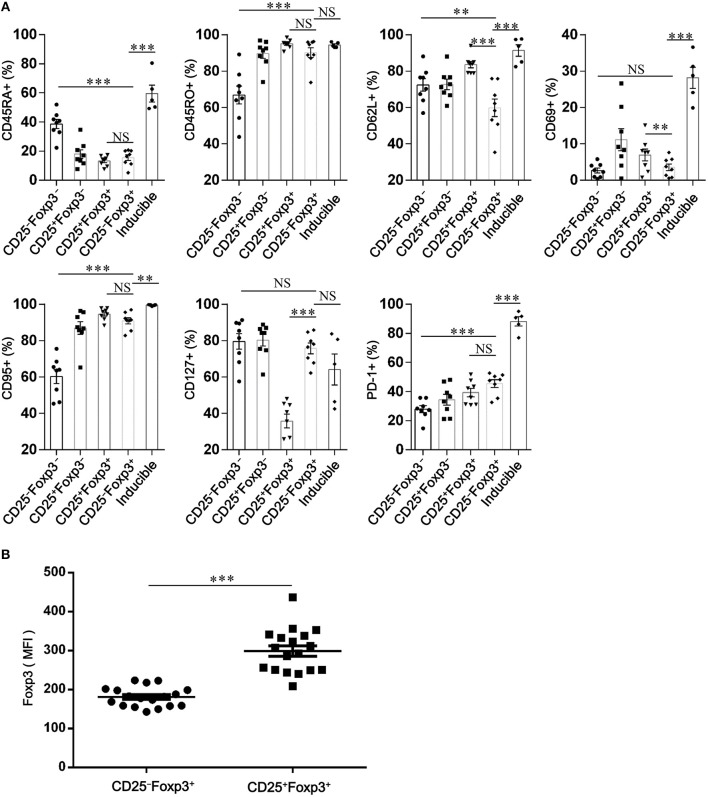
CD4+CD25−Foxp3+ T cells resemble activated conventional T cells in patients with chronic obstructive pulmonary disease (COPD). (A) Scatter plots depict the distribution of CD45RA, CD45RO, CD62L, CD69, CD95, CD127, and PD-1 amongst: peripheral CD4+ T cells subsets (CD4+CD25−Foxp3− T cells, CD4+CD25+Foxp3− T cells, CD4+CD25+Foxp3+ T cells and CD4+ CD25−Foxp3+ T cells) from SCOPD patients (n = 8) and inducible CD4+CD25−Foxp3+ T cells (Inducible, n = 5). Horizontal bars indicate means ± SEM. The comparisons among peripheral CD4+ T cells subsets were made using two-tailed paired t-test; the comparisons between peripheral CD4+ T cells subsets and inducible CD4+CD25−Foxp3+ T cells were made using two-tailed unpaired t-test, *P < 0.05, **P < 0.01, ***P < 0.001. (B) Expression of Foxp3 in peripheral CD4+CD25+Foxp3+ T cells and CD4+CD25−Foxp3+ T cells from COPD patients (n = 18) was measured by mean fluorescence intensity (MFI). Horizontal bars indicate means ± SEM. The comparisons were determined by two-tailed paired t-test, ***P < 0.001 compared with CD4+CD25+Foxp3+ T cells.